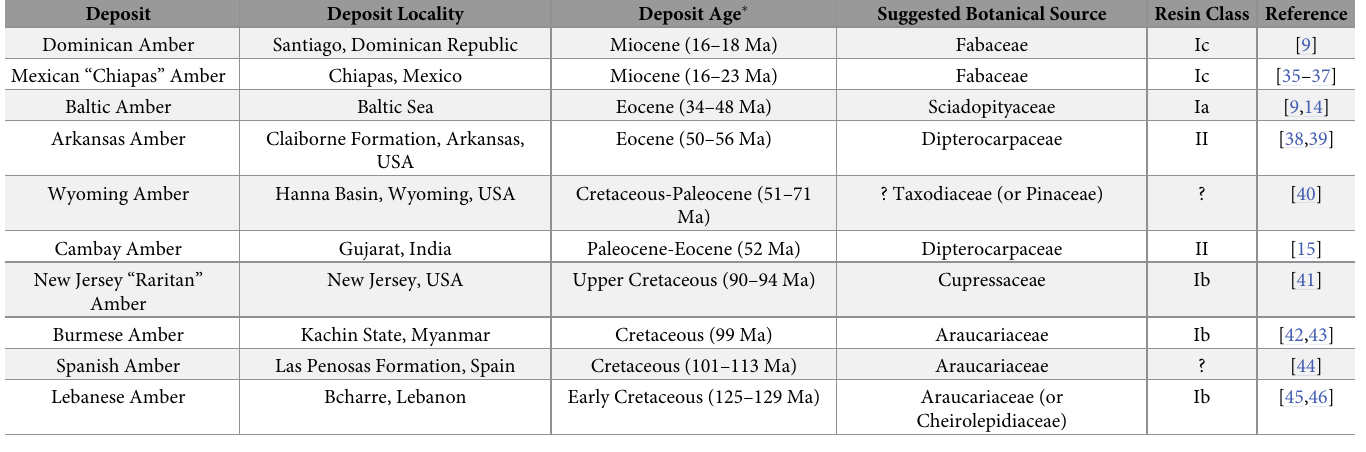
Table 1. Summary of amber deposits